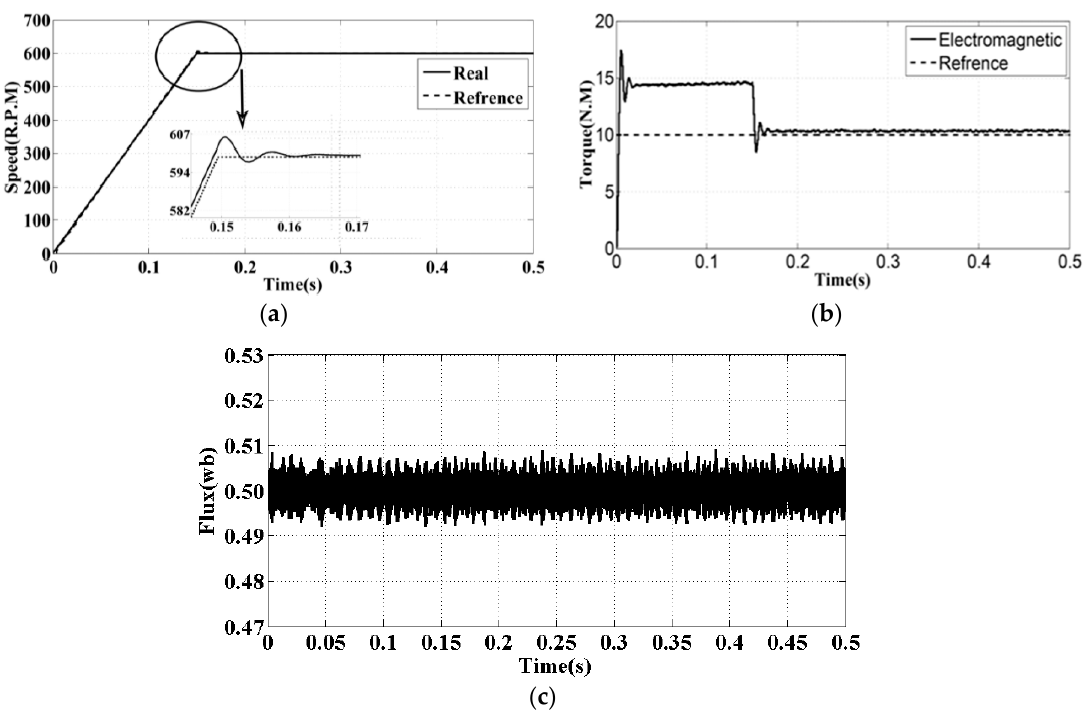
Figure 15. Characteristics of the motor compared with the reference. ( a ) Speed of the motor; ( b ) Electromagnetic torque; ( c ) stator flux in the α axis of the stationary frame.